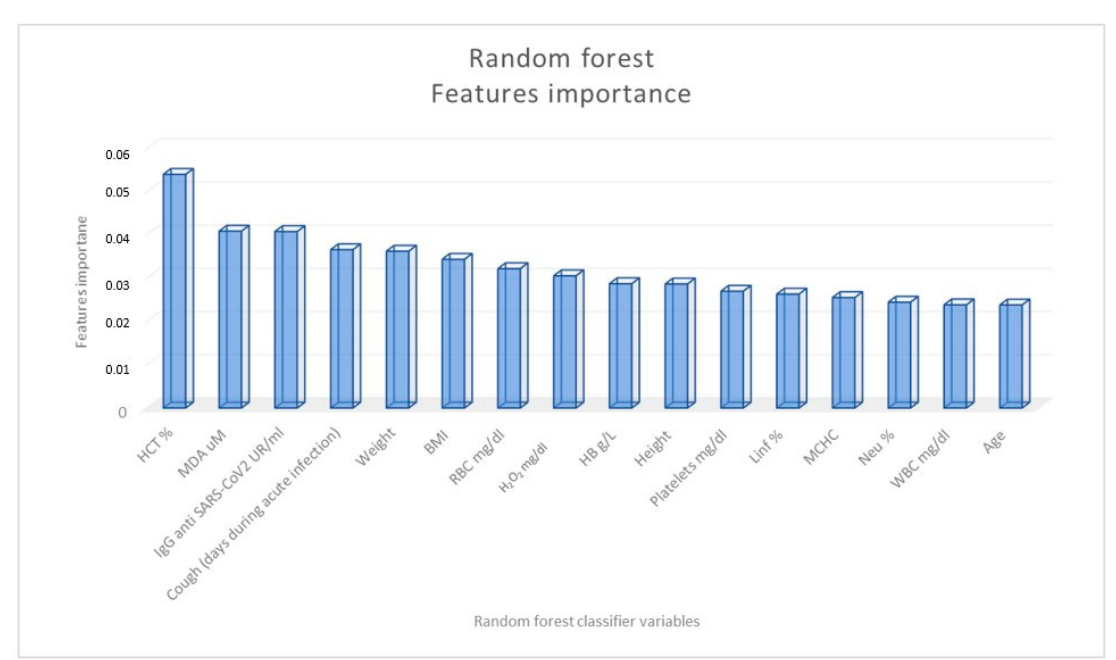
Figure 3. Importance of the random forest classification variables in distinguishing COVID-19 patients according to the presence (long-COVID patients) or not (non-long-COVID patients) of at least one symptom four months after negativization. Table 2. General characteristics and clinical parameters of COVID-19 patients subdivided according to the presence (long-COVID patients) or not (non-long-COVID patients) of at least one symptom four months after negativization.